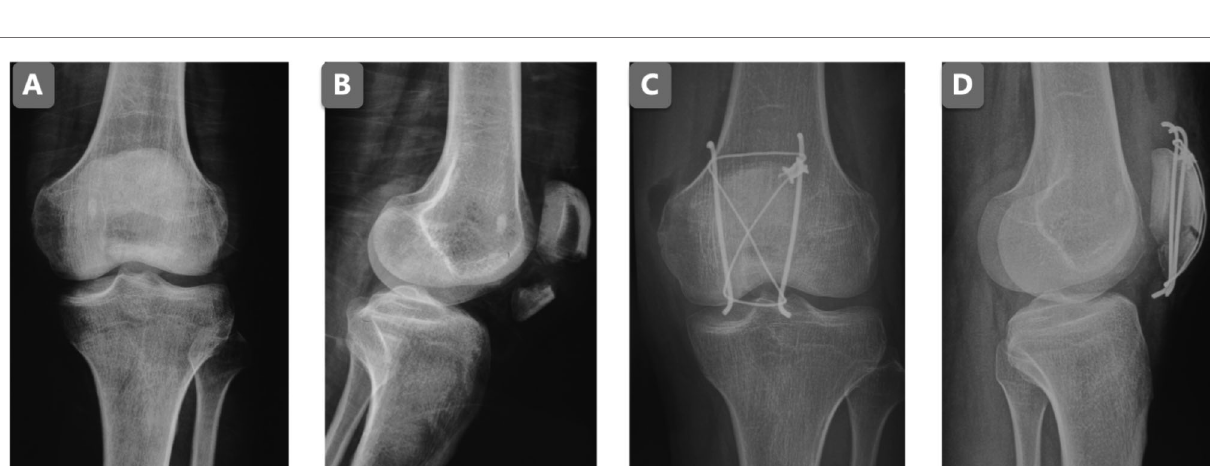
FIGURE 3 | The AP knee joint X-ray before the surgery ( A ); the lateral knee joint X-ray before the surgery ( B ); the AP knee joint X-ray post the traditional method surgery ( C ); the lateral knee joint X-ray post the traditional method surgery ( D